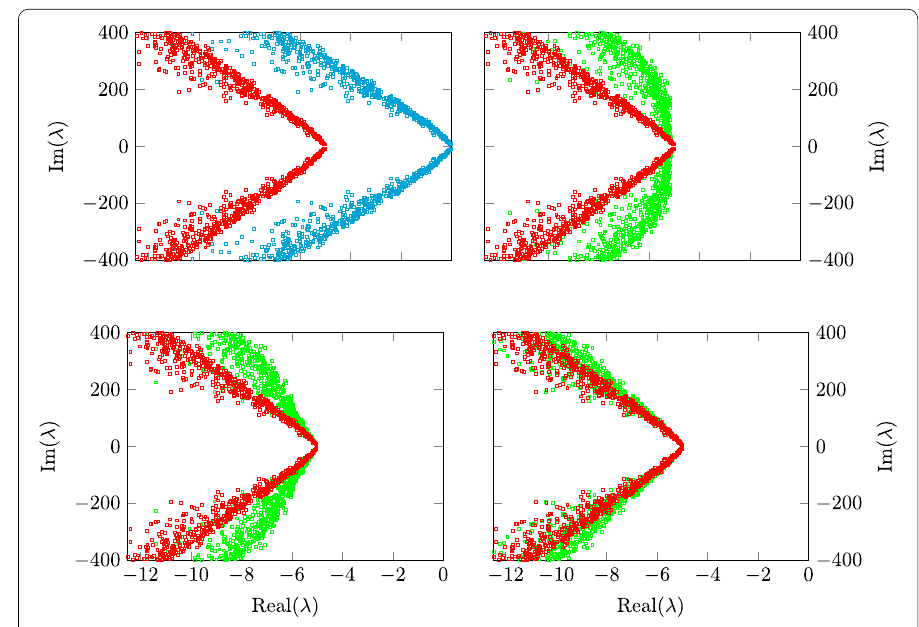
Fig. 11 Spectra of the time continuous operators. (North-West) : In (cyan) operators without filter, in (red) complete displacement observer. (North-East): In (green) (3D) tag planes with spacing 8mm. (South-West): In (green) (3D) tag planes with spacing 3 . 5mm. (South-East): In (green) (3D) tag planes with spacing 0 .